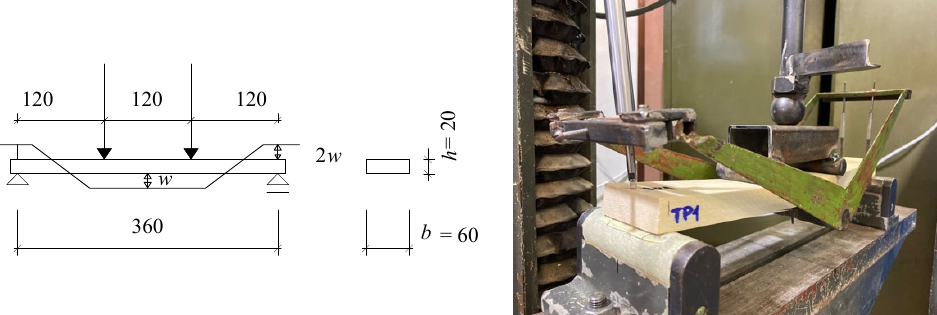
Figure 6. Arrangement of the test for strength and the modulus of elasticity in the lamellae bending test. Dimensions in mm.